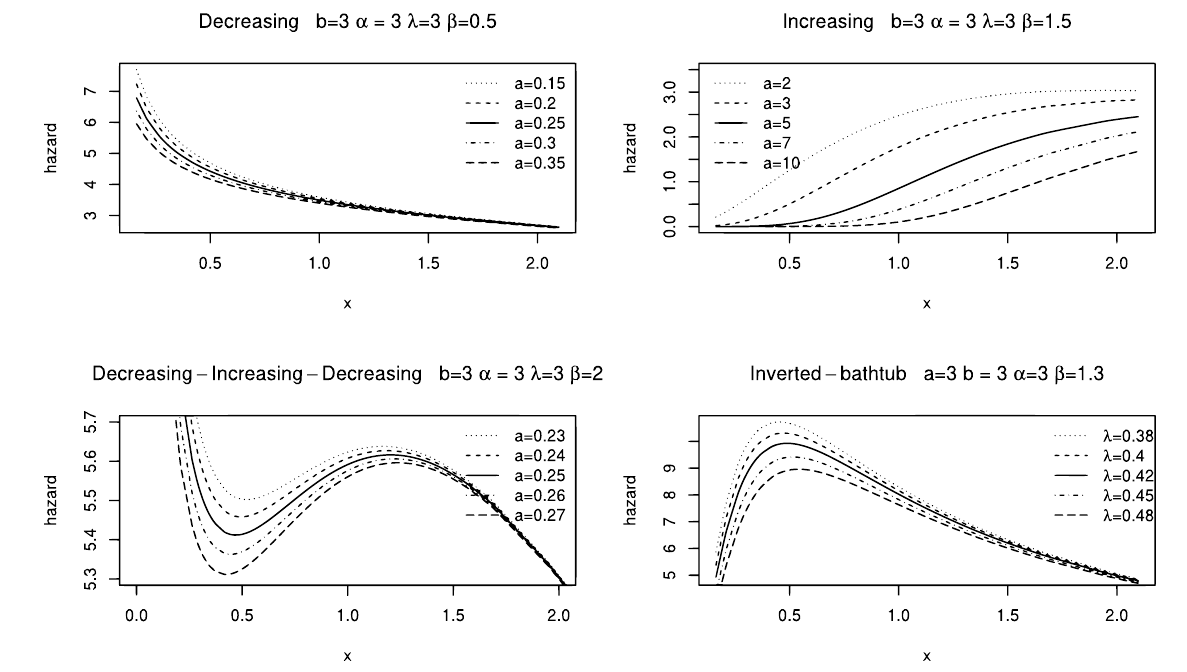
Figure 2. Shapes of the hrf of the KPL distribution at different parameter